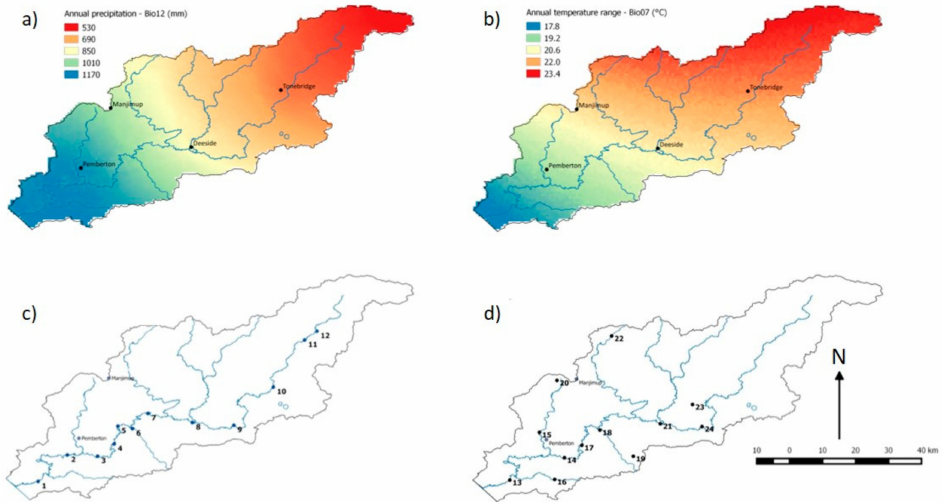
Figure 2. The gradient of ( a ) annual precipitation and ( b ) annual range in temperature across the study catchment with the locations of four weather stations marked. Climate gradients adapted from